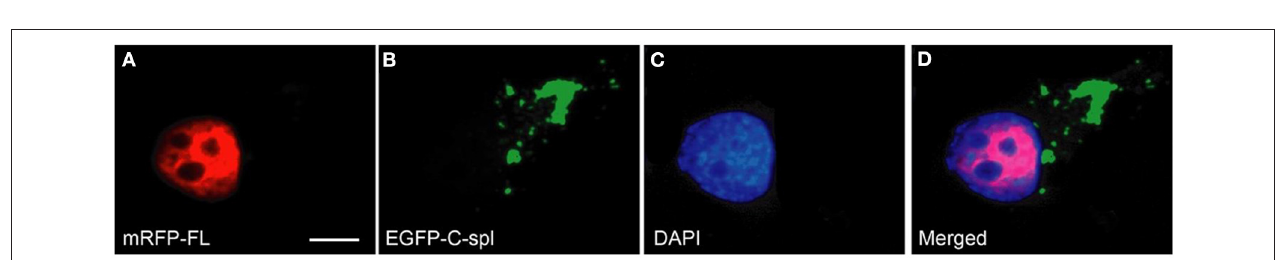
FIGURE 6 | TDP43C-spl aggregates do not recruit TDP43-FL. N2a cells were co-transfected with mRFP-tagged TDP43-FL (A) and EGFP-tagged TDP43C-spl (B) . Cells were counterstained with DAPI (C) . The merged image (D) shows that the localization of full length TDP-43 is confined to the nucleus [red in (A,D) ], whereas TDP43C-spl formed cytoplasmic aggregates [green in (B,D) ], that were devoid of full-length TDP-43. Scale bars = 30 µ